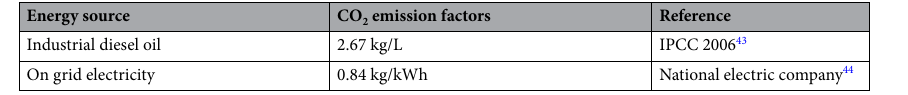
Table 2. The emission factors used for the container-handling equipment and auxiliary engines of the ships.